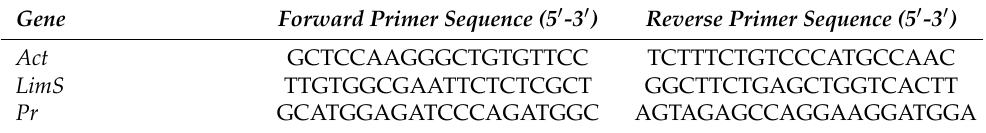
Table 1. Primer sequences for